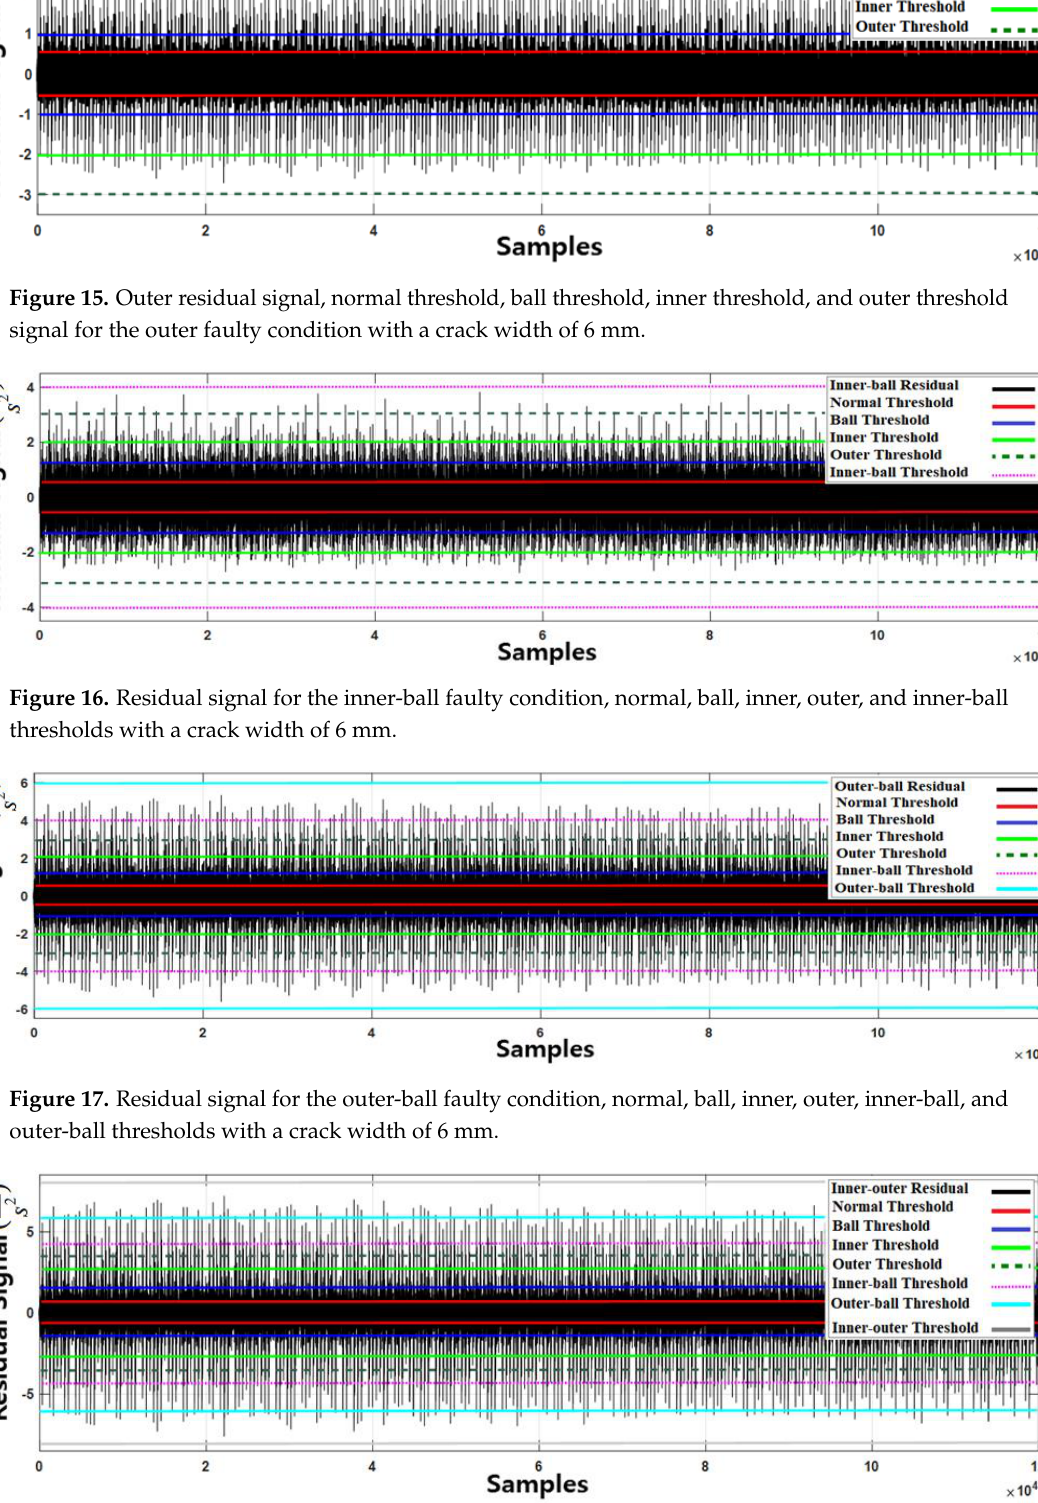
Figure 18. Residual signal for the inner-outer faulty condition, normal, ball, inner, outer, inner-ball, outer-ball, and inner-outer thresholds with a crack width of 6